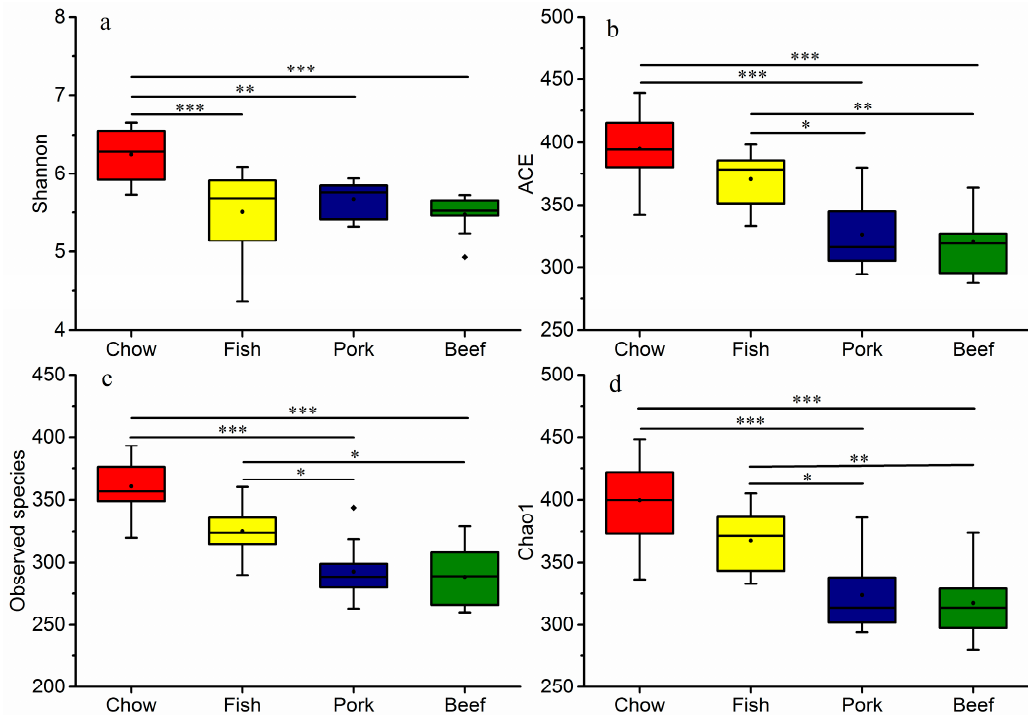
Figure 3. Differences in gut microbial diversity and richness in mice fed laboratory chow, fish, pork, or beef. Whiskers in the boxplot represent the range of minimum and maximum alpha diversity values within a diet group. The black dot inside or outside the boxplot are means and outliers, respectively. The horizontal line in the boxplot is the median. * p < 0.05, ** p < 0.01, *** p < 0.001. ( a ) Shannon diversity; ( b ) ACE; ( c ) Observed species; ( d ) Chao1.